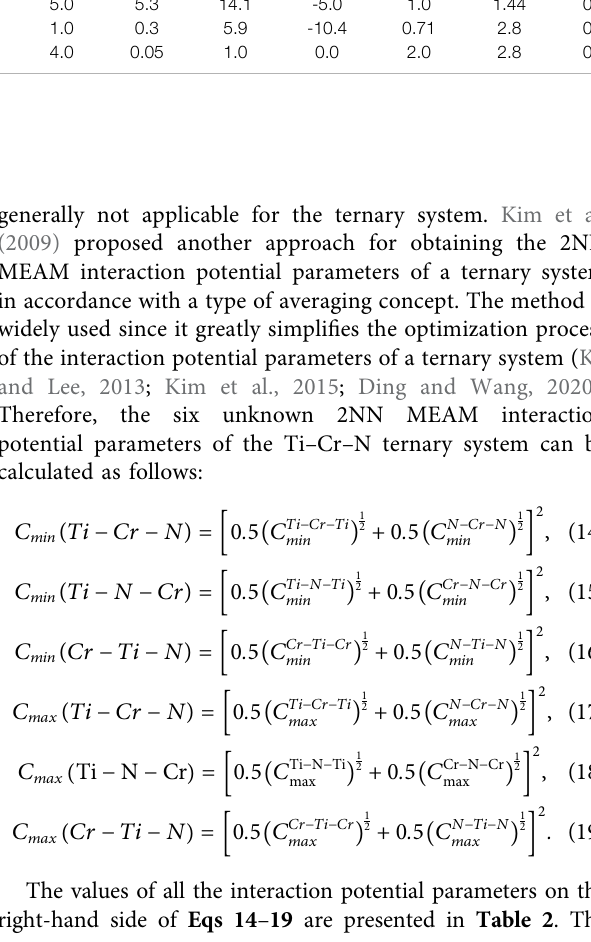
Frontiers in Chemistry |